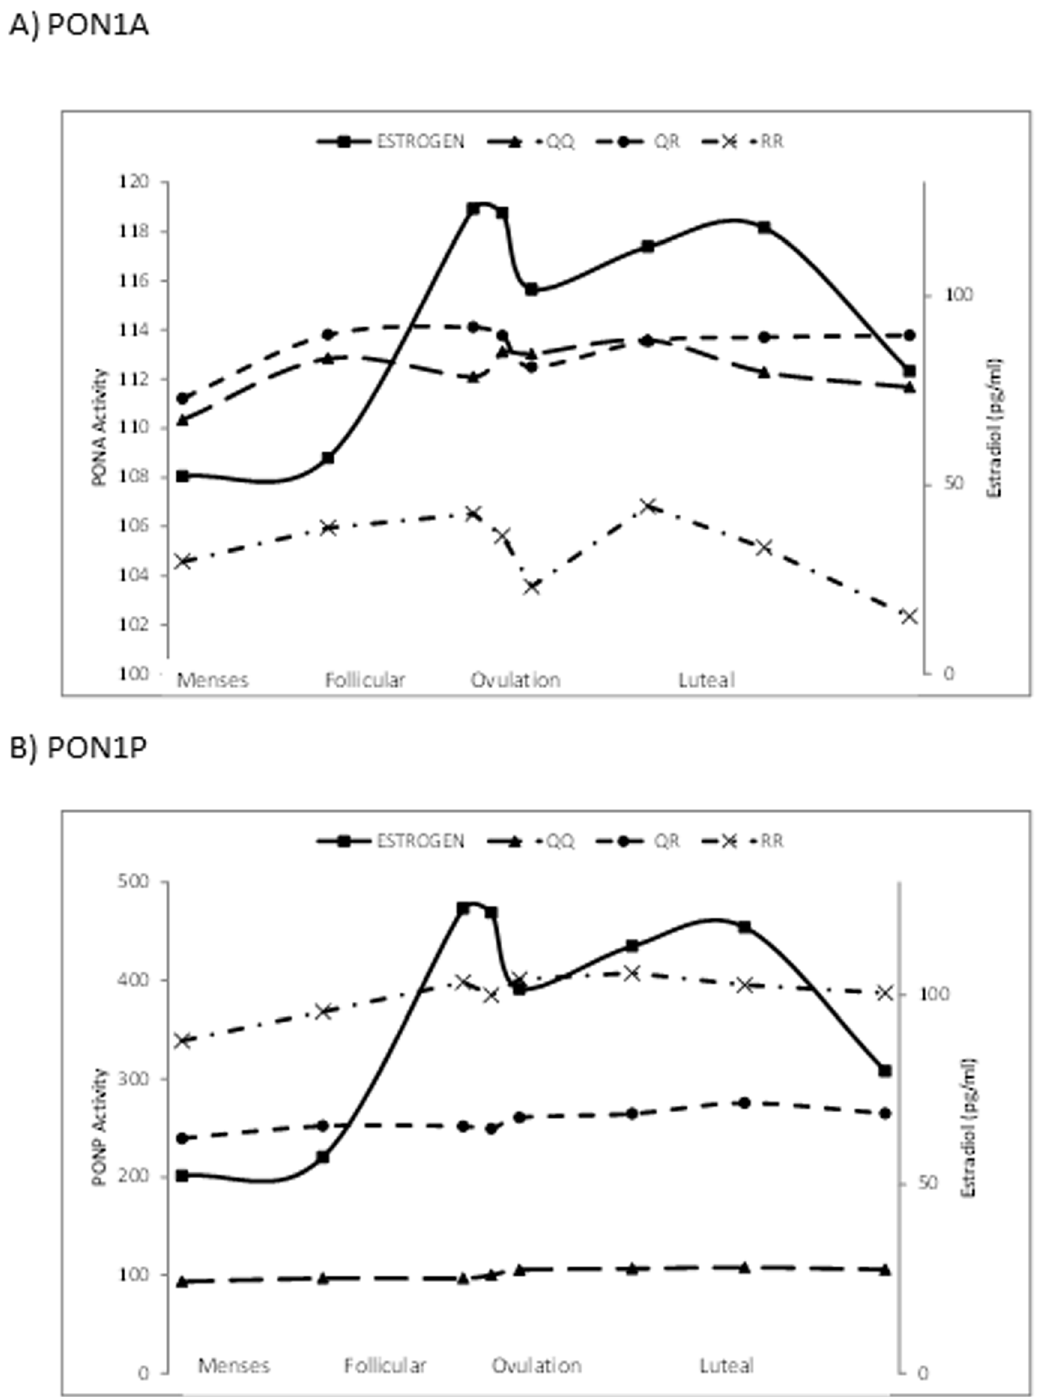
Figure 1. Geometric mean concentrations of estradiol, PON1A and PON1P across the menstrual cycle (N=497 cycles) by PON1 phenotype. further adjustment for isoprostane and 9-HODE, respectively (data not shown). Among those with the QQ phenotype, mercury was associated with a statistically significant 6.2% increase in PON1A (95% CI 0.2, 12.6).